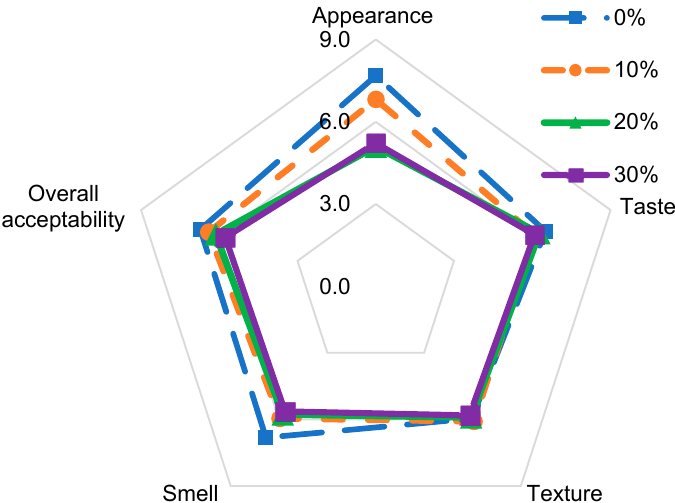
Figure 4. Sensory attributes of paneer control and rice milk incorporated samples.